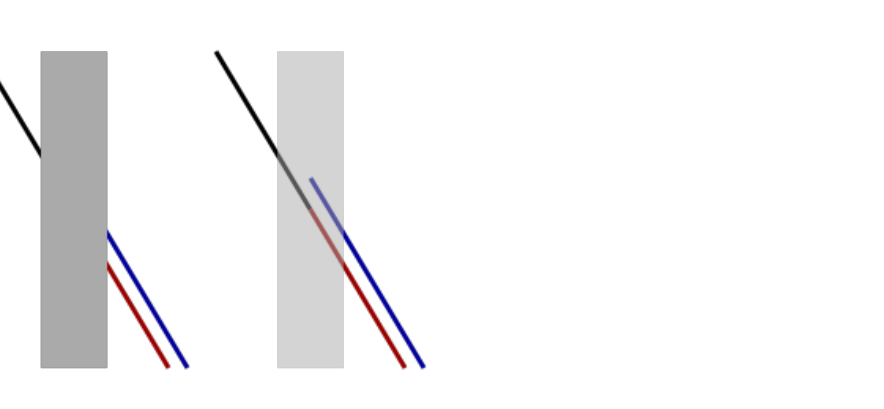
Figure 2. The original Poggendorff illusion: the red colored line is aligned with the black line although the blue one is falsely perceived as its continuation. Source: